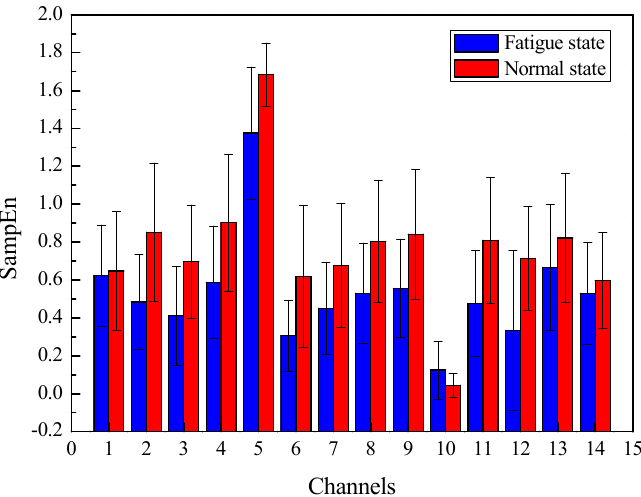
Figure 3. Mean and variance of the SampEn in the different channels.